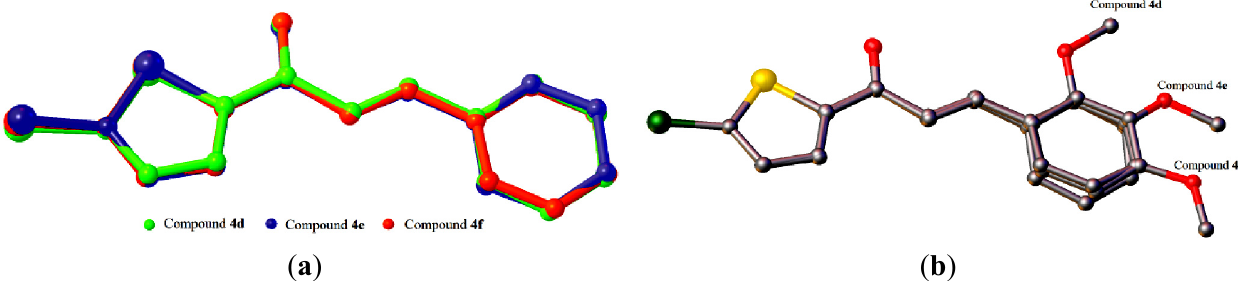
Figure 7. ( a ) Overlay of all non-H atoms, where the methoxy groups were excluded. ( b ) Overlays were calculated using the chlorothiophene moiety in compounds 4d , 4e and 4f . Hydrogen atoms have been omitted for clarity. Only molecule A in compound 4d is chosen for the overlay